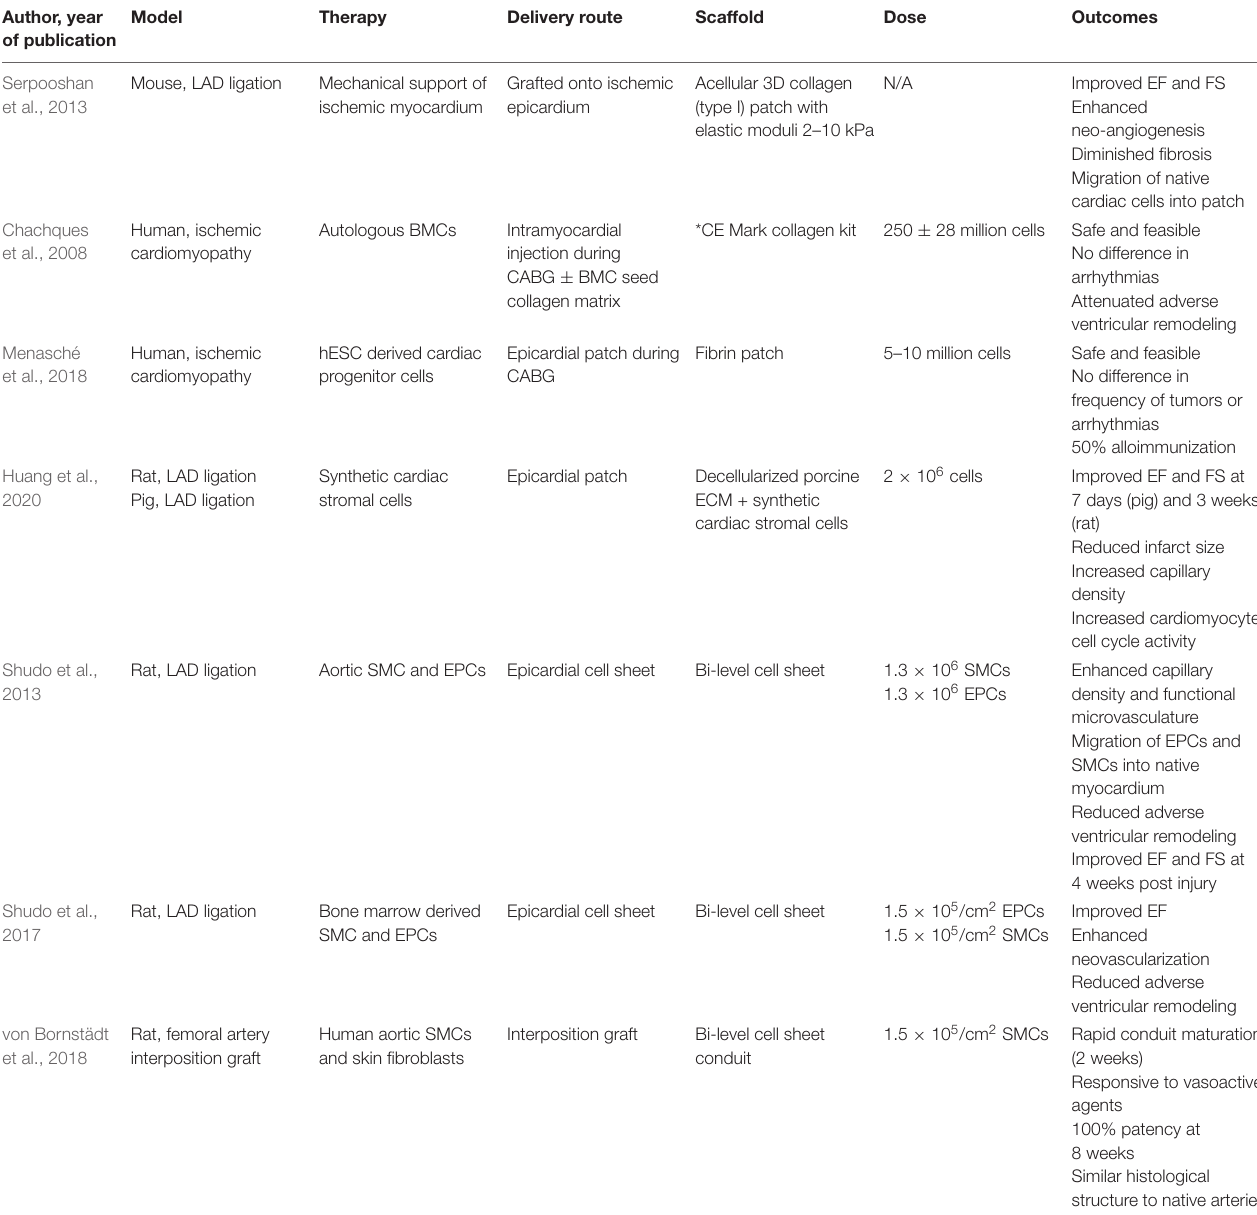
TABLE 2 | In vivo tissue engineering approaches to myocardial